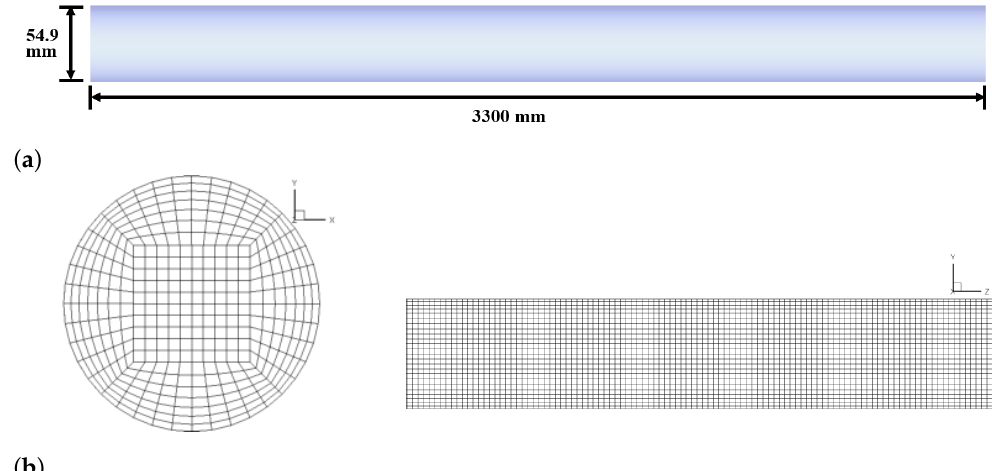
Figure 2. Geometry of the computational domain-( a ) and the axial and cross-section view of compu- tational Grid-2 (456,000 cells)-( b